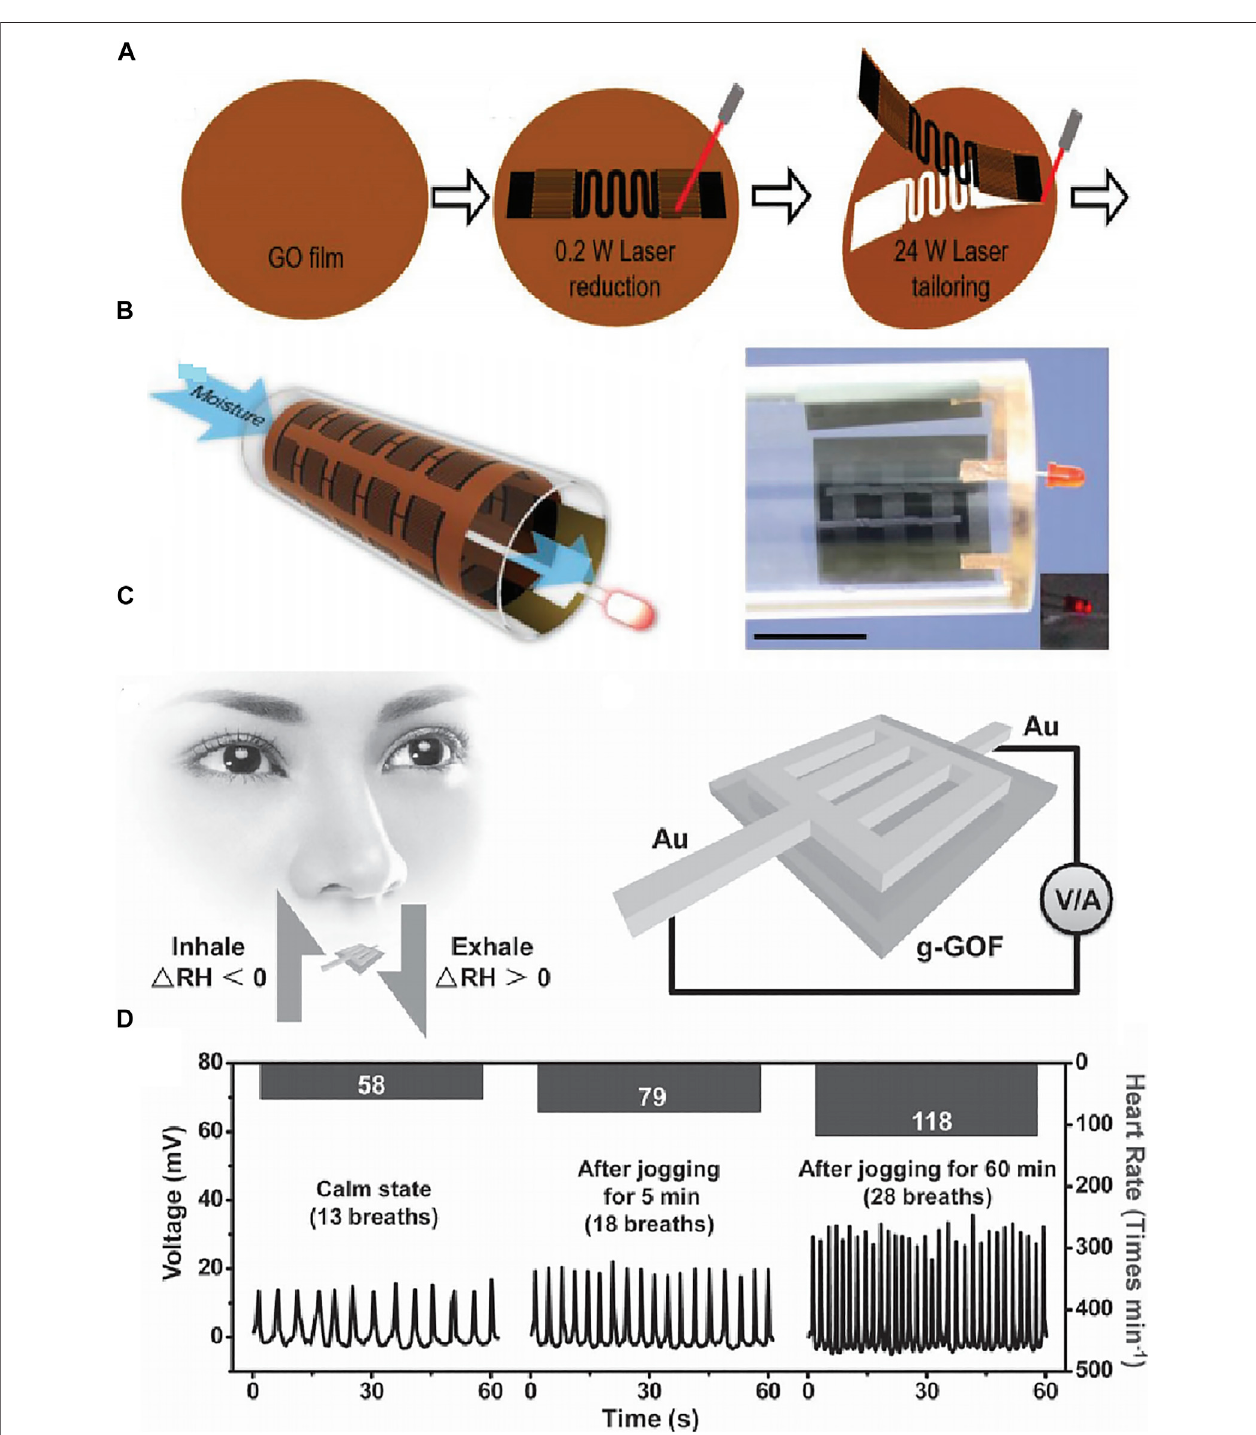
FIGURE 6| (A) Schematic illustration ofthe process of MEG preparation. The rGO inter digital electrodes and circuits were reduced by direct laser writing, and the freestanding MEG device was fabricated by programmable laser. (B) Scheme and optical images of rolled GO fi lm with multiple GHEG devices powering an LED bulb once a man exhales moisture through the small tube. Scale bar: 20 mm (images reprinted from ref. 83 with permission. Copyright 2019; Wiley Online Library). (C) MEG device that is responsive to RH changes induced by human breathing. To construct the MEG device, the g-GOF is sandwiched between two gold electrodes with vents. (D) Voltage and current outputs generated by a respiratory moisture-tide with Δ RH ≈ 21% (Figure reprinted from ref. 79 with permission. Copyright 2015; Wiley Online Library).